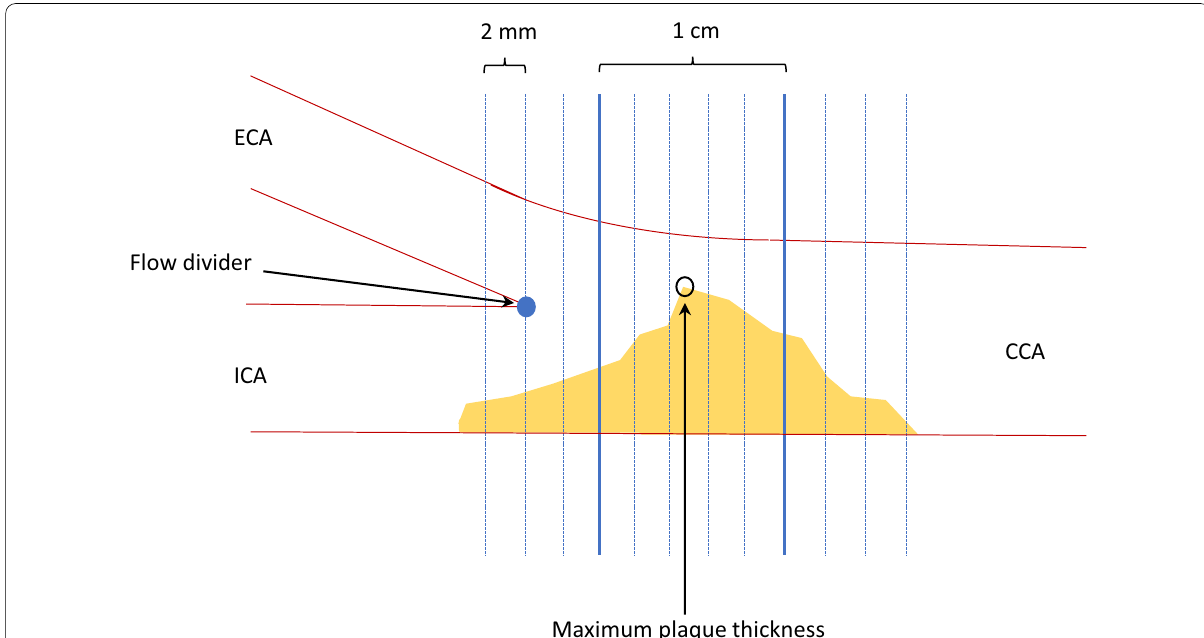
Fig. 1 Schematic example of the calculated average max standardized uptake value (aSUV max ) and grayscale median (GSM). ECA artery. ICA internal carotid artery. CCA common carotid artery. The 3D ultrasound acquisition of the plaque was sliced in 2-mm segments from = = the flow divider, and the slice containing the maximum plaque thickness was identified. The slice with the maximum plaque thickness and the two slices on each side were used in analyses. For the PET/CT, the flow divider was used as landmark for alignment of SUV max readings to the ultrasound readings. An average SUV max was calculated for this 1 cm long plaque volume. GSM was automatically calculated by the software for the volume of the 10-mm-long plaque